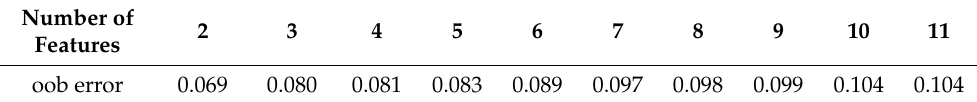
Table 2. OOB error.